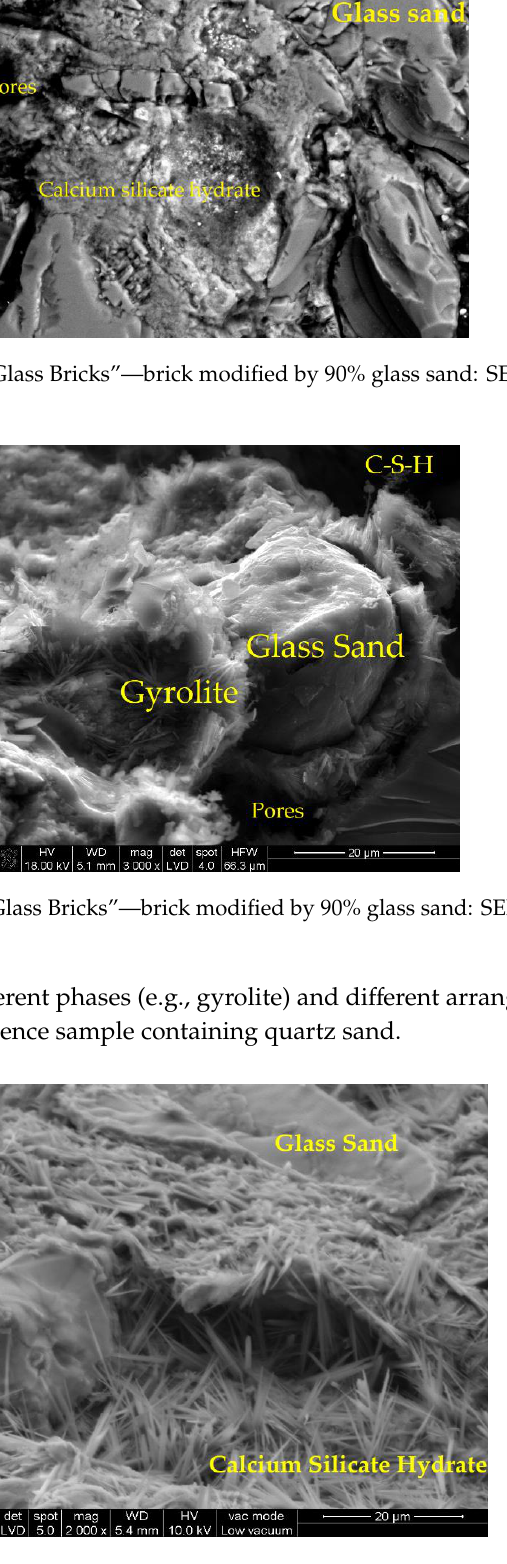
Figure 19. SEM image of “Glass Bricks” — brick modified by 90% GS, high-vacuum mode 2000× mag.